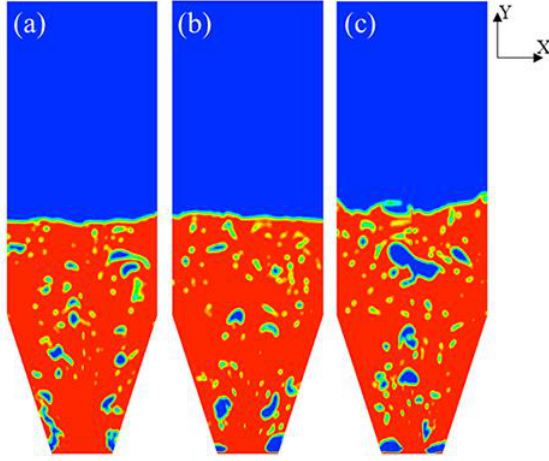
Figure 4. Distribution of bubbles at different inlet velocities; ( a ) 15 m/s, ( b ) 30 m/s, ( c ) 60 m/s.